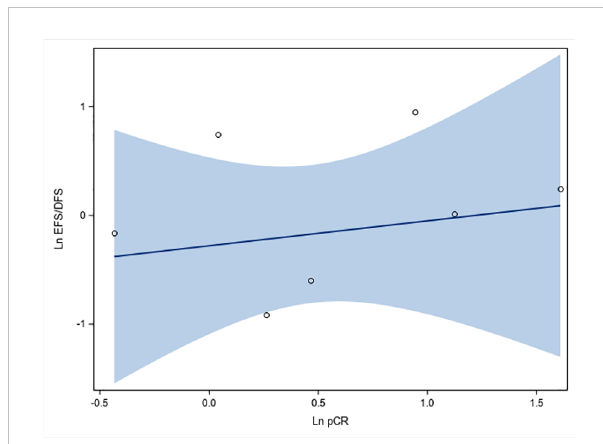
FIGURE 4 Fit plots and fi t statistics for correlation between log OR for pCR and log HR for EFS/DFS. Each individual circle of the graph represents HR data point from a single study. Solid blue line indicates the fi tted weighted linear regression line. DFS, disease-free survival; EFS, event-free survival; Ln, natural logarithm; OS, overall